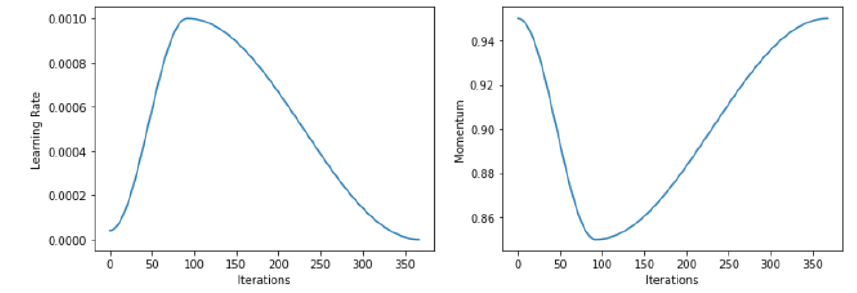
Figure 8. The hyper-parameters schedule in the 1cycle policy.